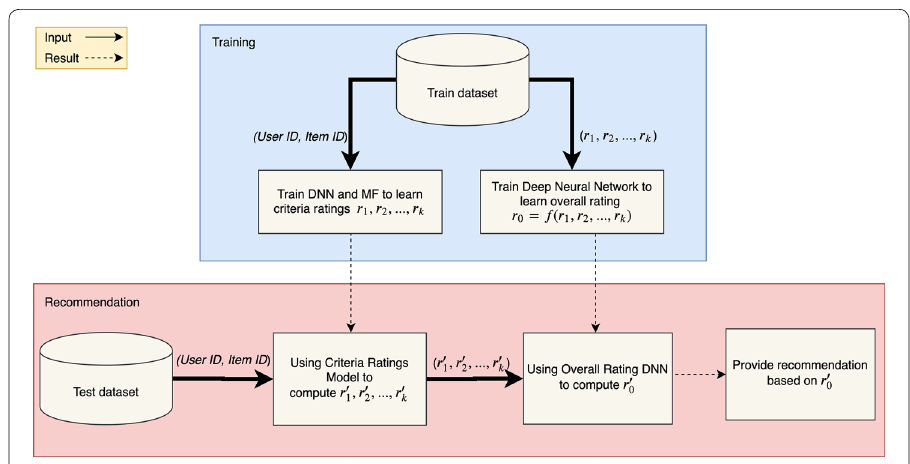
Fig. 1 The framework of the proposed model, including two steps: the Training and the Recommendation